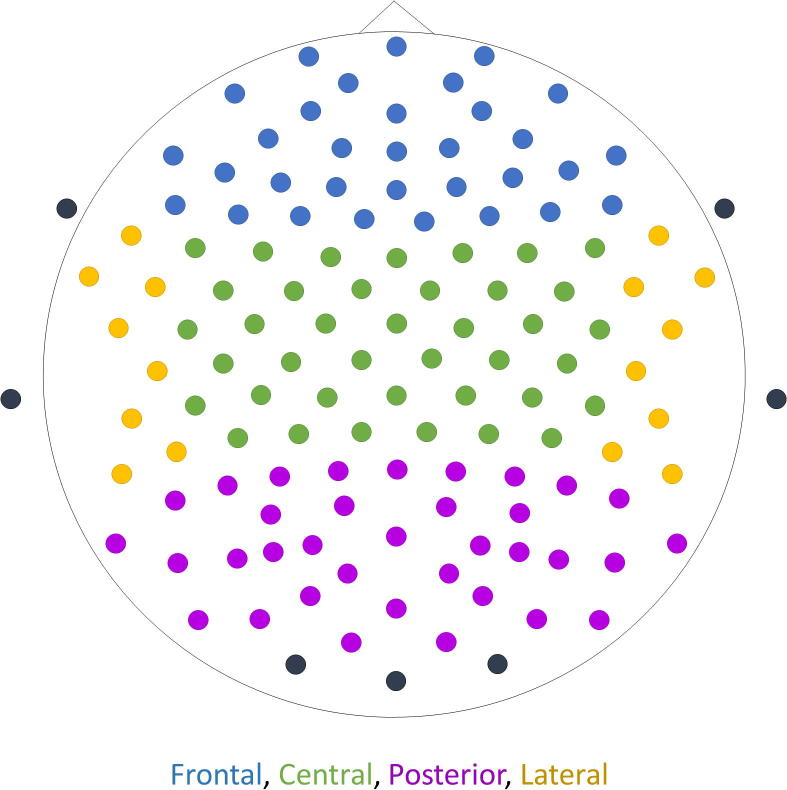
Placement of the 128 electrodes according to the 10-5 placement system. The signal recorded from the electrodes indicated with black colour was selected out as it was deemed too noisy. The colours indicate the grouping of the electrodes into four regions: blue = frontal, green = central, purple = posterior, yellow = lateral. (For interpretation of the references to colour in this figure legend, the reader is referred to the web version of this article.)